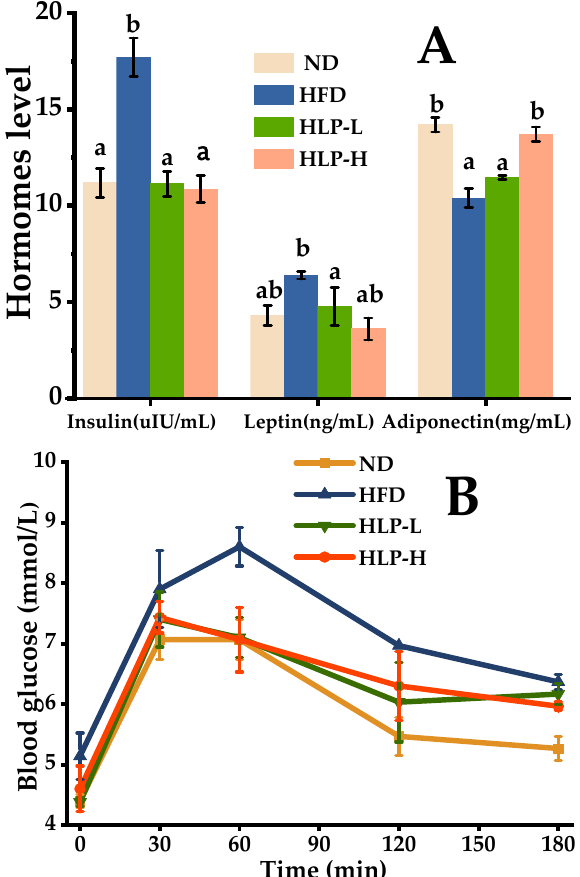
Figure 2. Effects of HLP on adiponectin, insulin, and leptin level ( A ); glucose response curve during the insulin tolerance test ( B ). Data are presented as means ± SEM ( n = 8). Values with different superscripts represent significant differences ( p < 0.05).